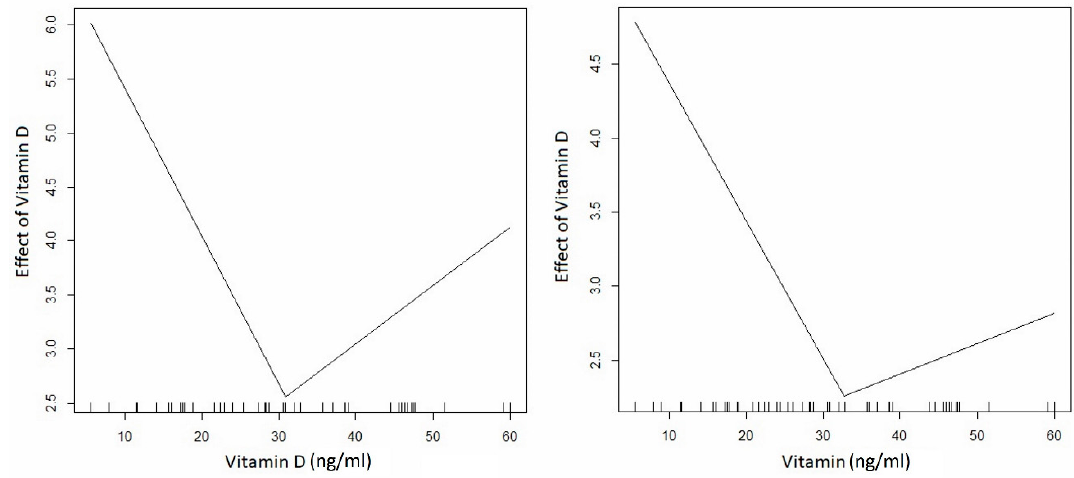
Figure 4. E ff ects of vitamin D on AMH in serum and follicular Figure 4. Effects of vitamin D on AMH in serum and follicular fluid.